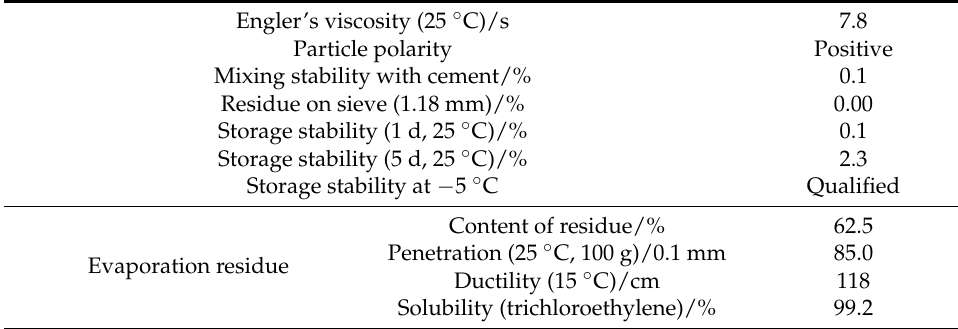
Table 1. Properties of the asphalt emulsion.